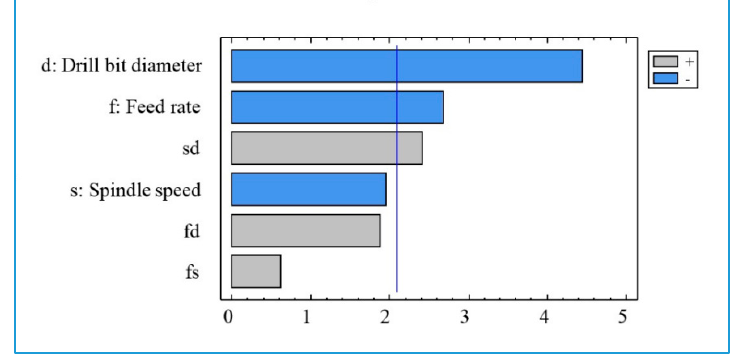
Figure 17. Pareto diagram for total number of fine particles (PM 10 ).